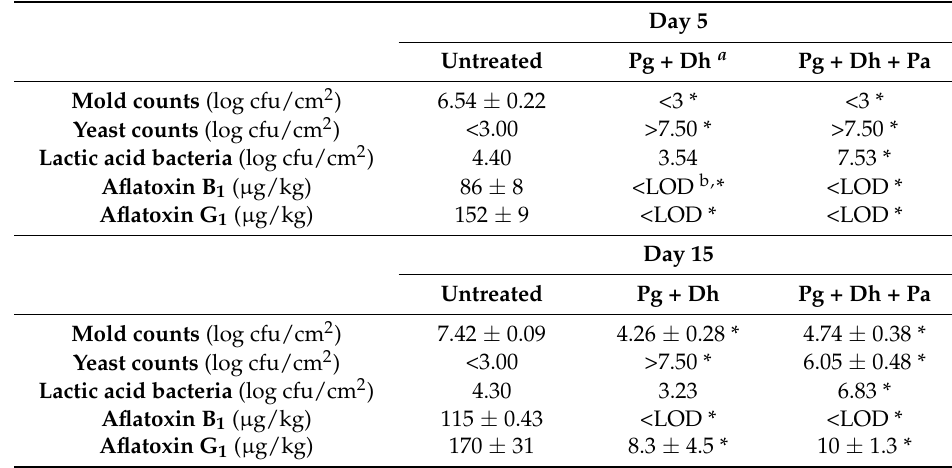
Table 2. Aflatoxins concentrations and microbial counts on slices of dry-fermented sausage at five and 15 days of incubation. Data are given as mean ±